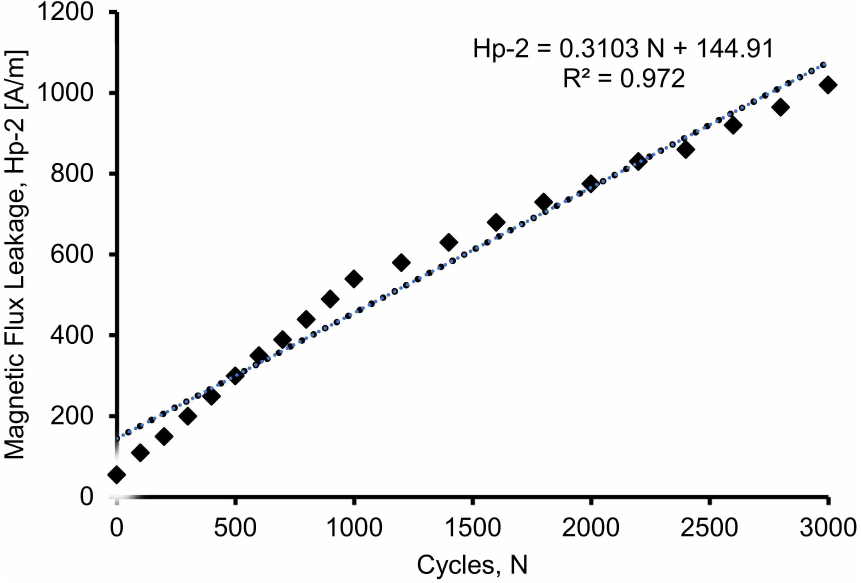
Figure 10. Magnetic flux leakage signals at critical distance for 10 mm high yield steel